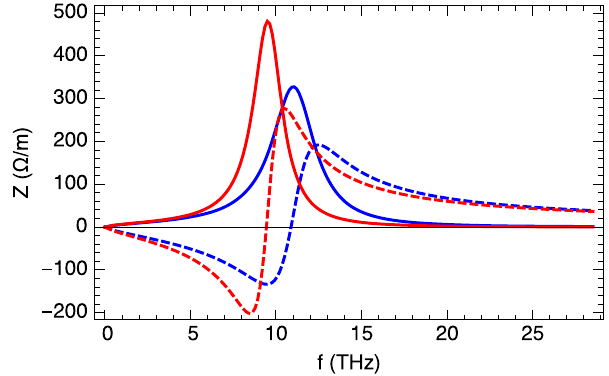
FIG. 1. For round geometry: real (solid lines) and imaginary (dashed lines) parts of the impedance (7) for copper (red) and aluminum (blue).